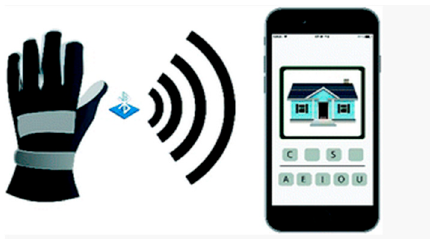
Figure 3. Design of an electronic glove for teaching vowels for deaf children. In [31].